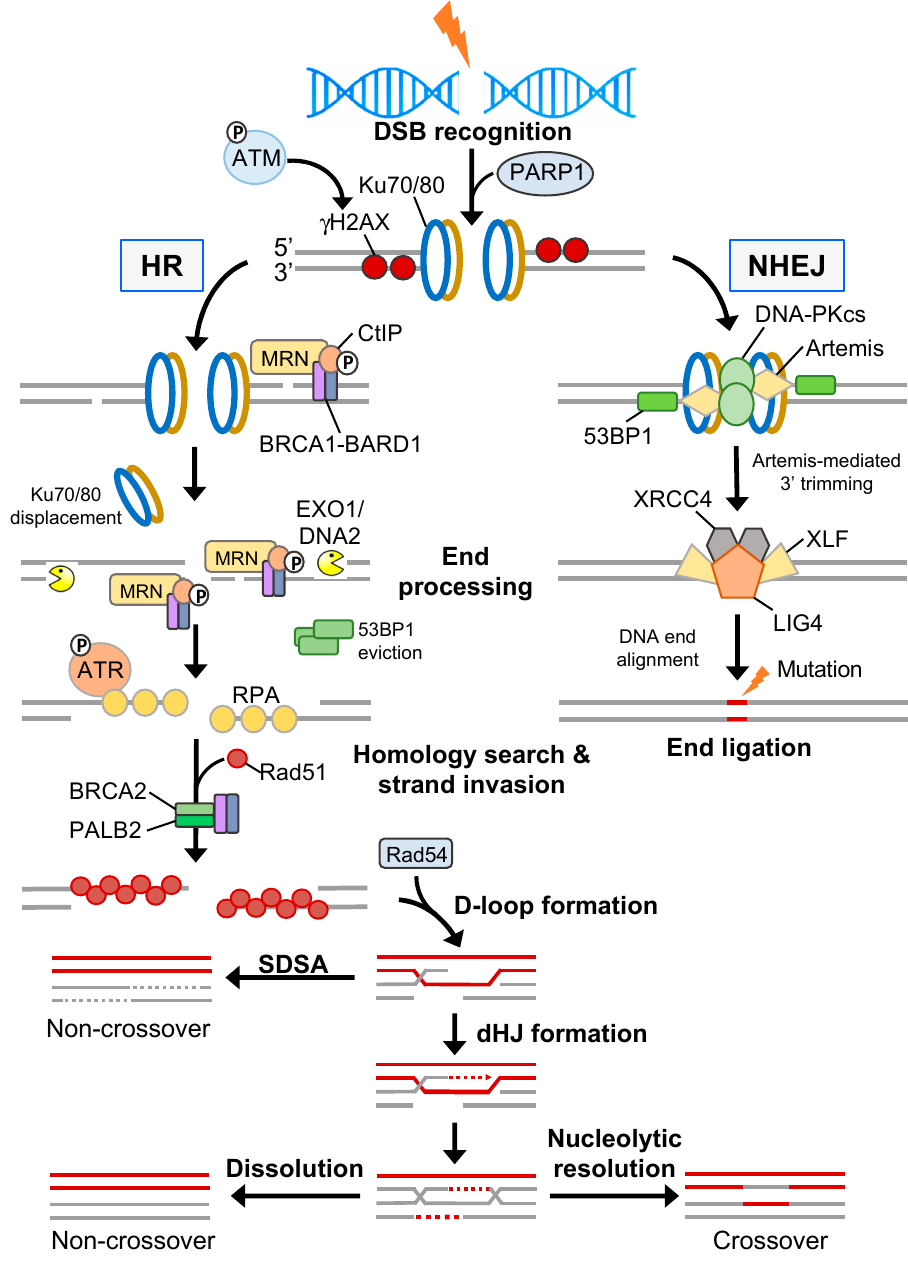
Figure 3. Homology- and non-homology-directed DSB repair. NHEJ is driven by the DNA-PKcs axis and re-joins two broken ends directly which usually leads to small DNA sequence deletions.